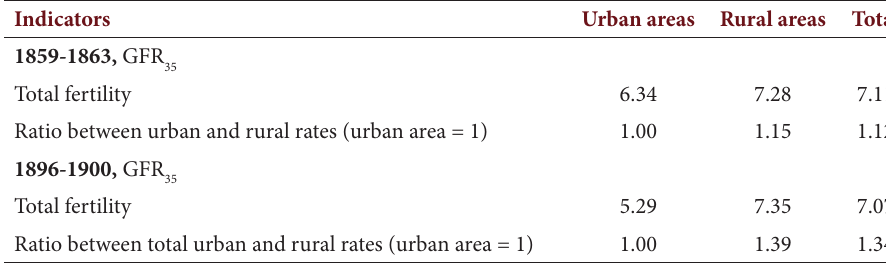
Table 4. Total fertility (GFR35) among women aged 15-49 in European Russia in 1859-1863 and 1896-1900. Indicators